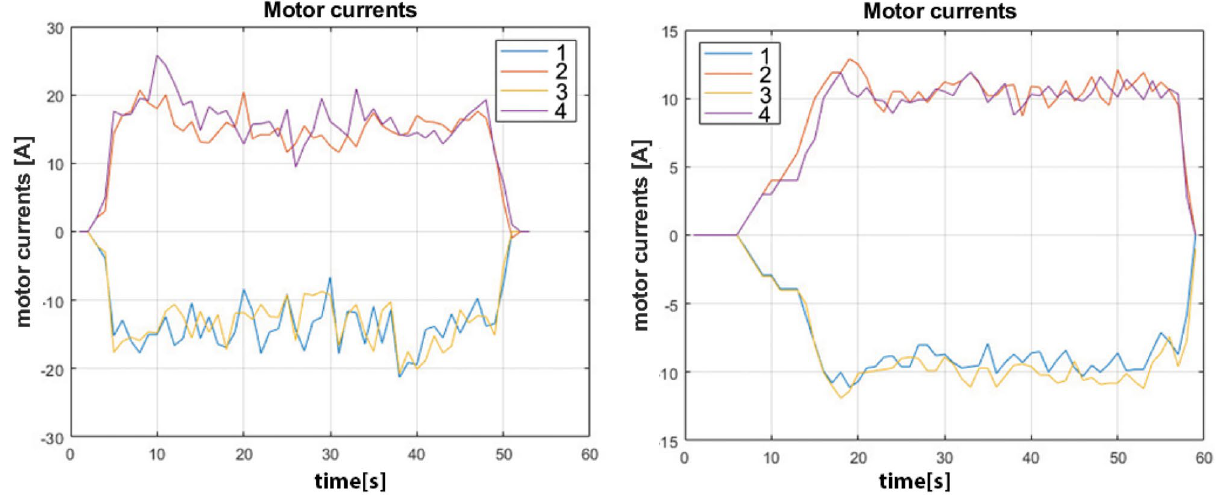
Figure 12. Currents drawn by motors during sideways motion on asphalt, on the left, and on concrete, on the